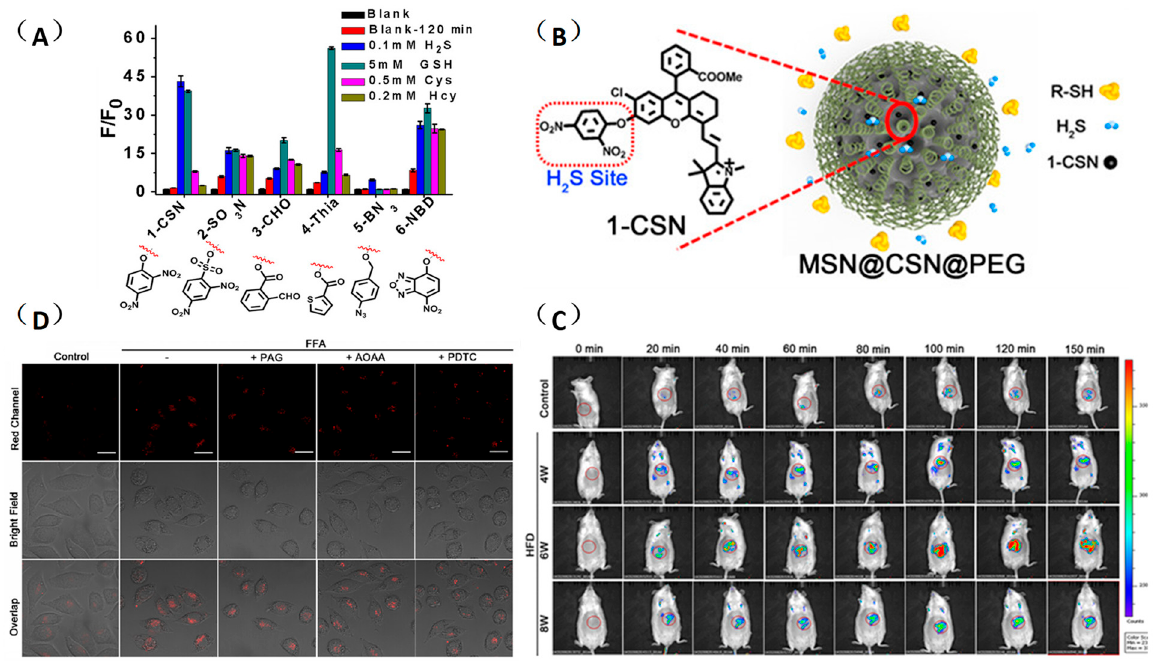
Figure 16. ( A ) Screening of the near-infrared H 2 S molecular probe. ( B ) Nanofunctionalization of 1-CSN . ( C ) Imaging of H 2 S levels in normal liver cells (HL-7702) and NAFLD cell model with probe MSN@CSN@PEG (100 μ g/mL). ( D ) Real-time in vivo fluorescence imaging of hepatic H2S levels in mice at different stages of NAFLD by intravenous injection of the probe MSN@CSN@PEG (100 µ L, 10 mg/mL). [46] Copyright © 2023 American Chemical Society .